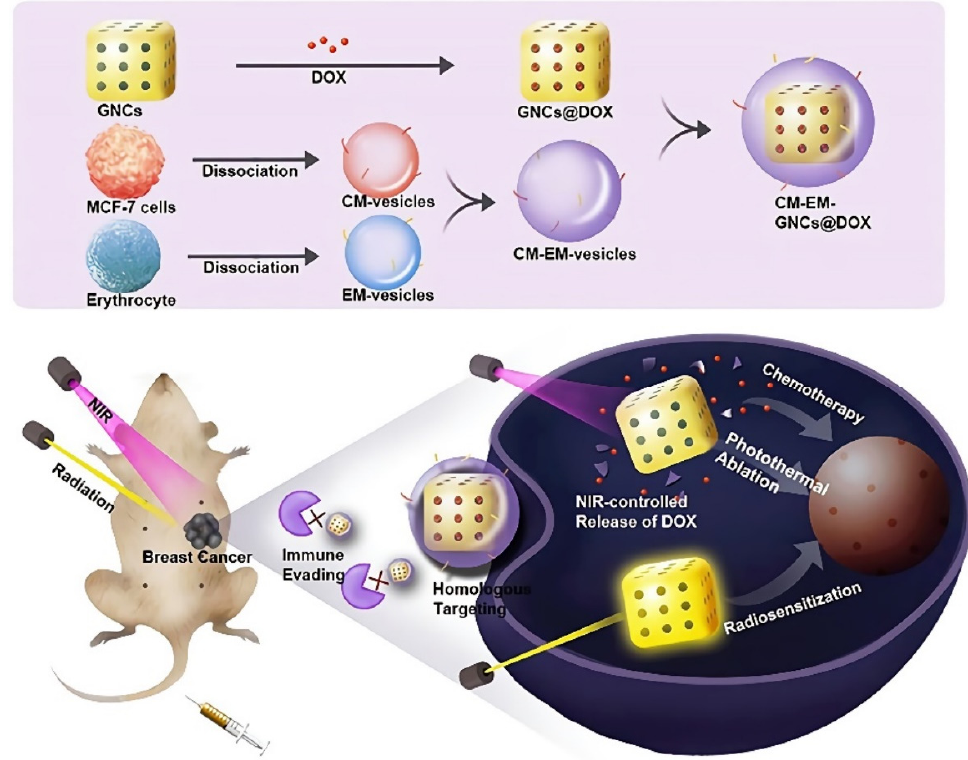
Figure 6. Schematic illustration of CM-EM-GNCs@DOX with NIR-responsive drug release properties for combined photothermal/radiation/chemotherapy of breast cancer. Reprinted/adapted with permission from Ref. [68]. Copyright 2020, Sun et al.